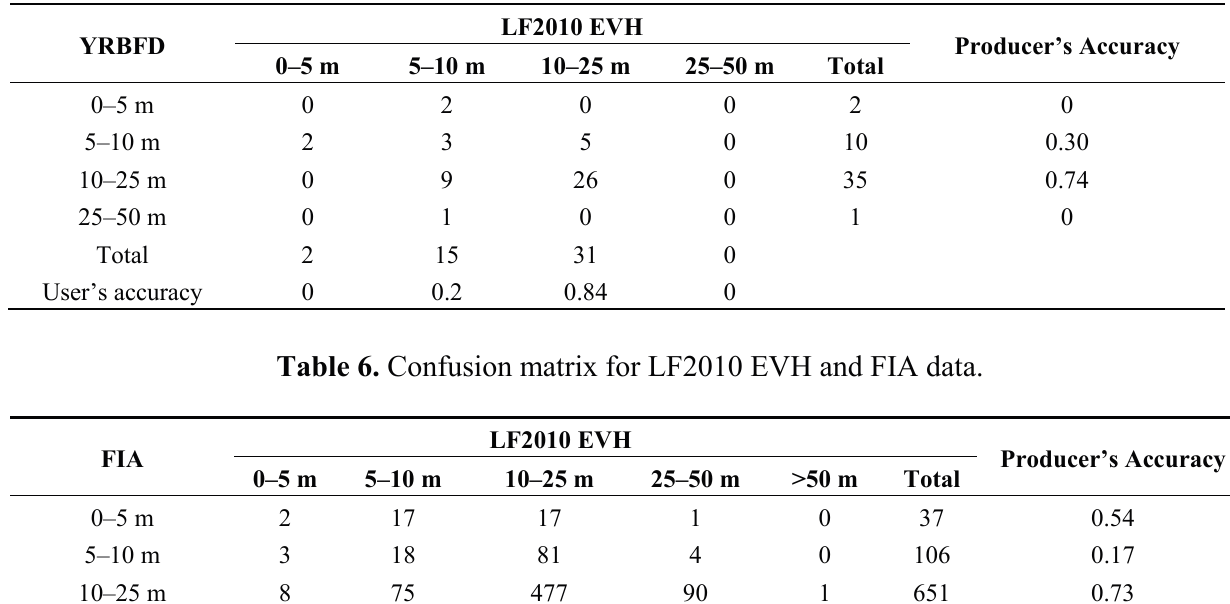
Table 5. Confusion matrix for LF2010 EVH and YRBFD.